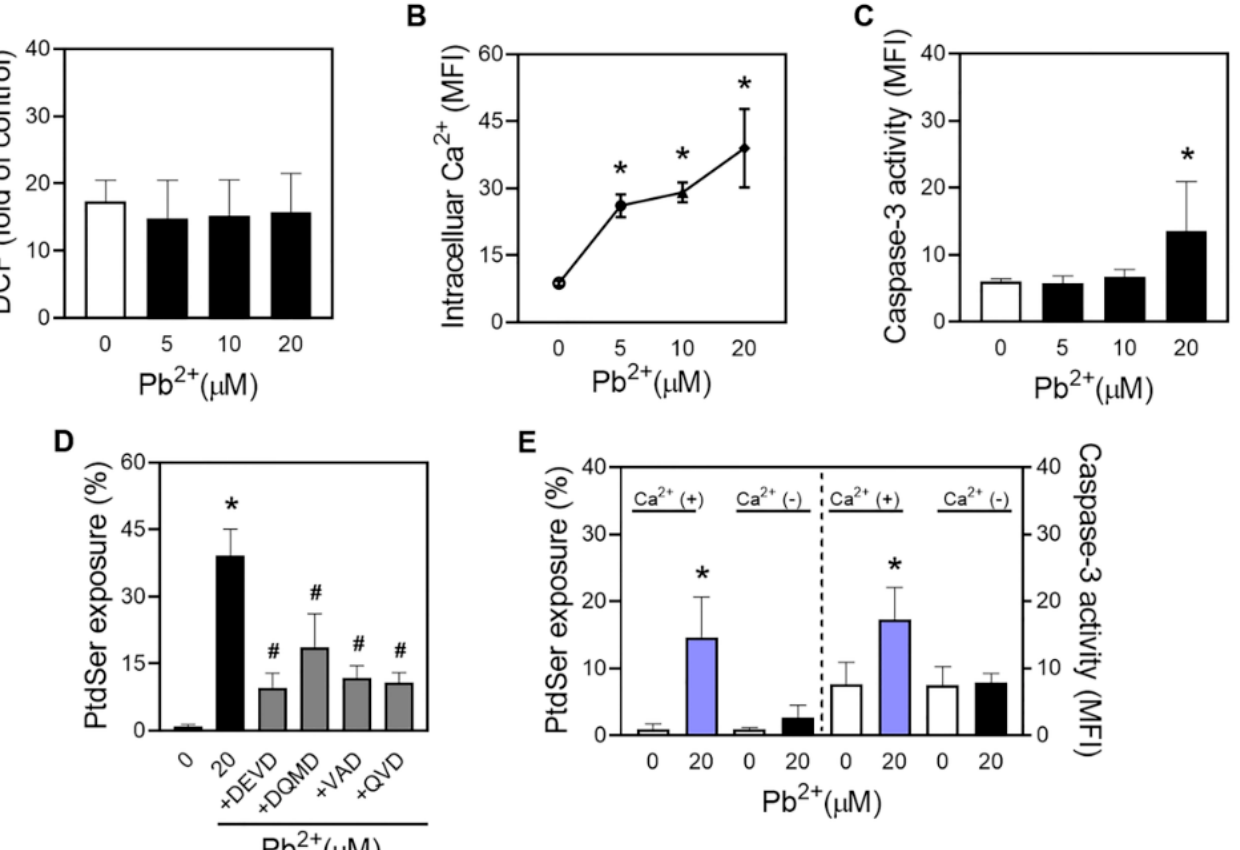
Figure 3. ROS-independent but [Ca 2+ ] i -dependent eryptosis by Pb-treated erythroid cells. Isolated human erythroid cells were treated with various concentrations (0, 5, 10, and 20 μ M) of Pb at 37 °C for 1 h. ( A ) DCF is a method to determine the content of intracellular reactive oxygen species by using flow cytometry. ( B ) Intracellular calcium level was examined by preloading 3 μ M fluo-4 AM for 1 h. ( C ) Caspase 3 activity was measured as shown in the Materials and Methods section. ( D , E ) Inhibition of PtdSer exposure and caspase 3 activity was performed by preloading various caspase inhibitors or a calcium-chelating agent (TPEN) as shown in the Materials and Methods section. Values are the mean ± SD of 3–5 experiments. * Statistical difference compared with control ( p < 0.05). # Statistical difference compared between groups ( p <